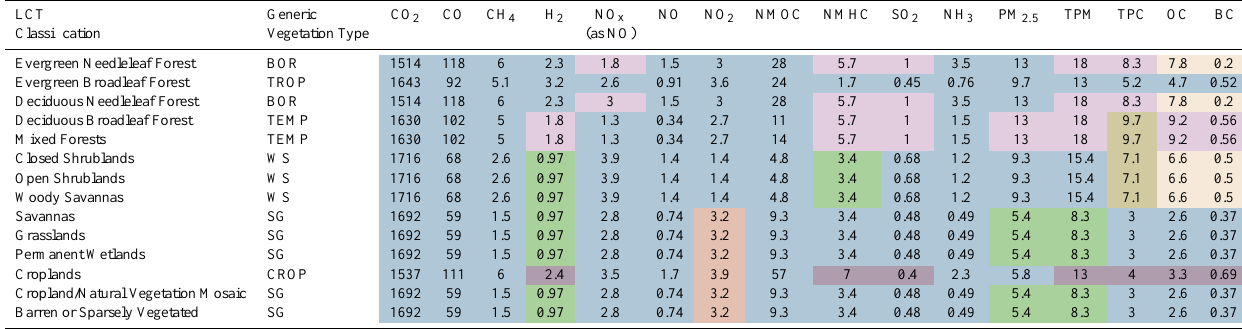
Table 1. Land use/land cover classifications as assigned by the MODIS Land Cover Type, assigned generic land cover class, and emission factors (gkgBiomass Burned − 1 ) . Sources of emission factors are by